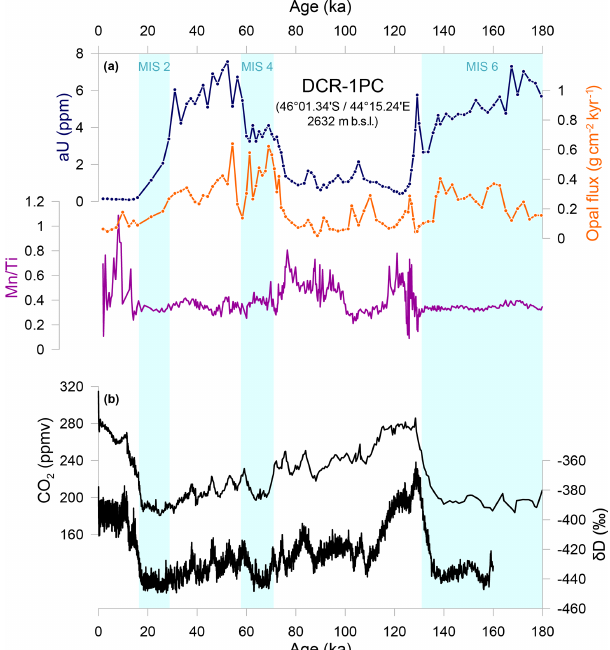
Figure 3. (a) Authigenic uranium concentrations (in blue), opal fluxes (in orange), and Mn / Ti ratios (in purple) from XRF scan- ning of sediment core DCR-1PC in the Subantarctic Zone. (b) At- mospheric CO 2 concentrations from EPICA Dome C ice core, the composite record (Bereiter et al., 2015, and references therein), and the δ D record from EPICA Dome C ice core, reflecting Antarctic air temperatures (Jouzel et al., 2007). Light blue bars show cold periods MIS 2, 4, and 6 (Lisiecki and Raymo,